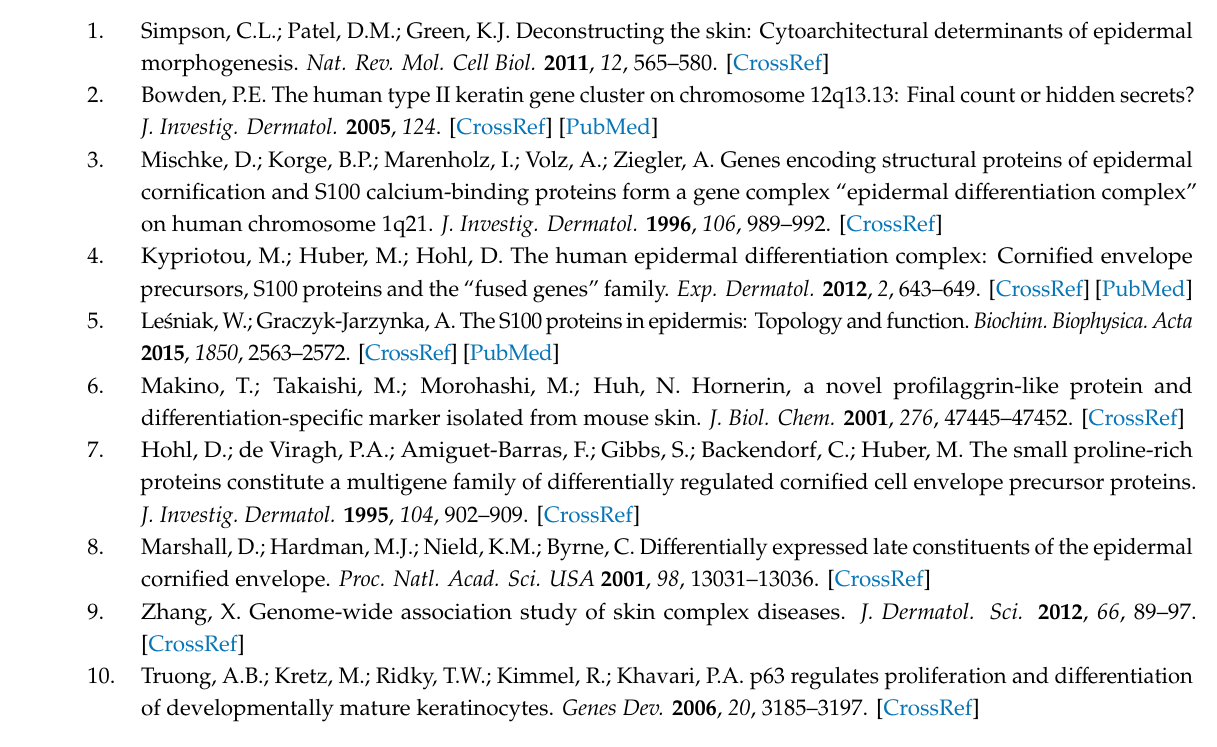
Figure S1. Upper panel: chromatograms showing sequencing results for C2 (WT) and C1 / C3 (mutated) cell clones. The mutated fragment is indicated by a black horizontal bar. Lower panel: the corresponding nucleotide and amino acid sequences. Supplementary Figure S2: relative level of integrin β 1 mRNA in WT (white bar) and SUV-KO (gray bar) HaCaT cells. * p ≤ 0.05. Supplementary Table S1: the list of primers used in RT-qPCR. The primers for LCE1 genes are as in